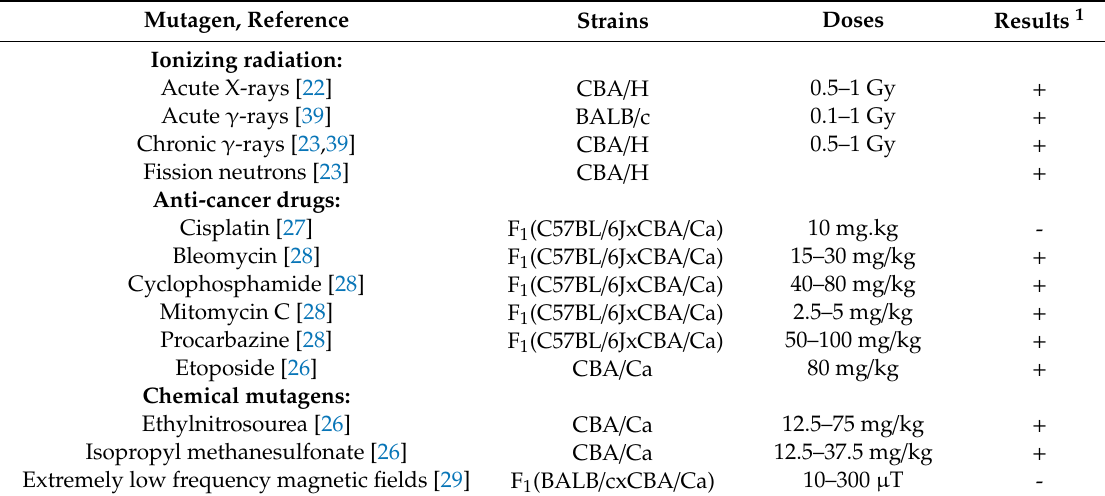
Table 1. ESTR mutation induction in the germline of male